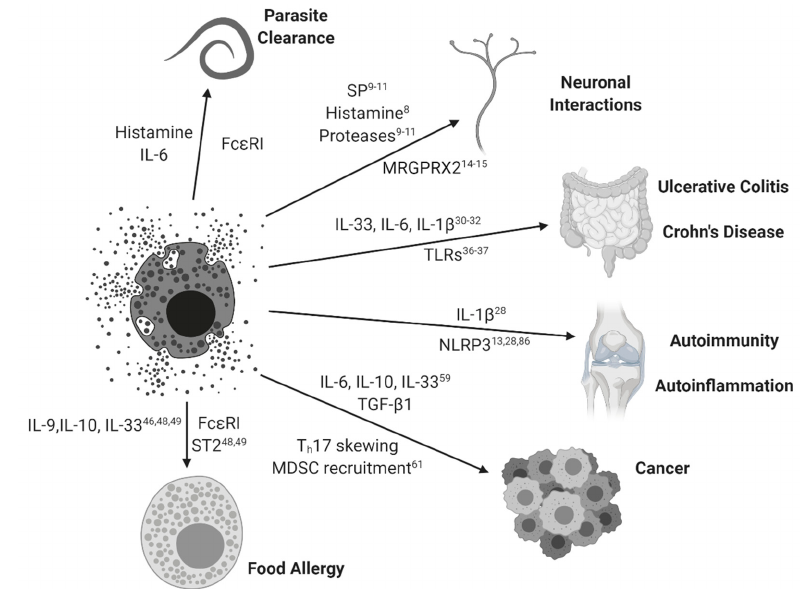
Figure 1. Mast cell activation paradigms. Mast cells and their simplified interactions with clinical diseases are represented with arrowed connections. Relevant MC-mediated soluble factors and associated signaling pathways are represented for each disease state. Subscripts correspond to relevant references from this review.